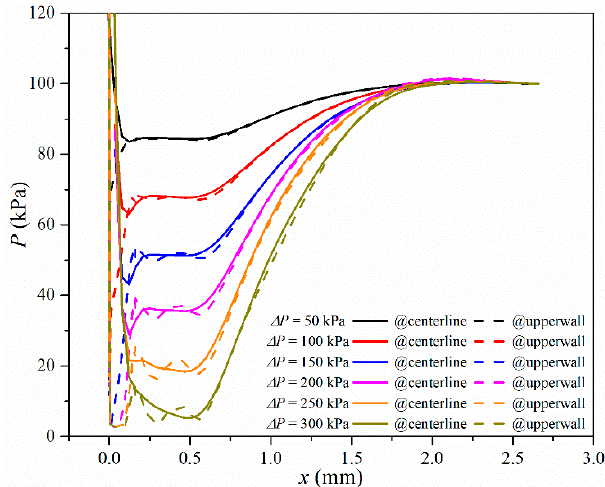
Figure 6. Pressure along two different locations on the symmetry plane.